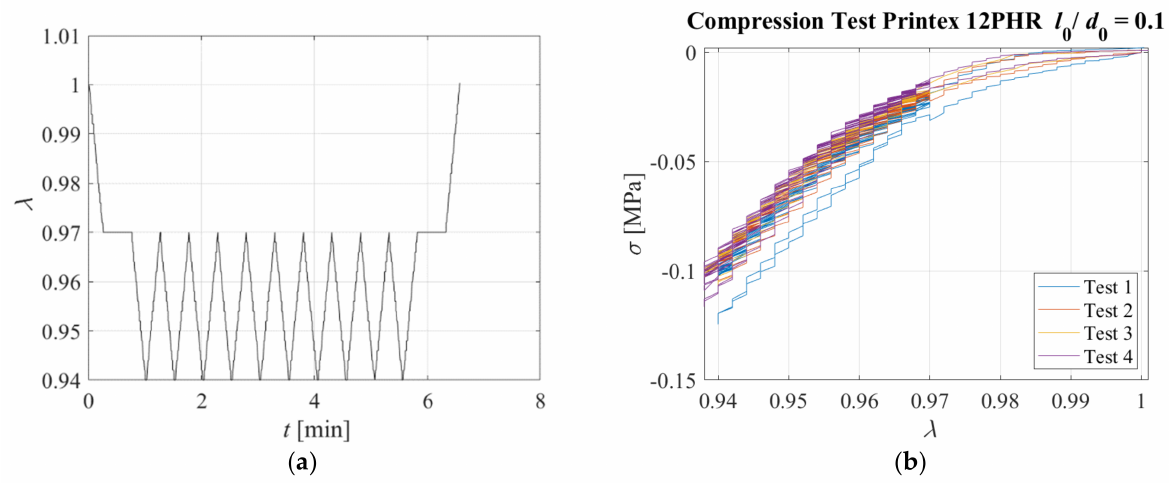
Figure 23. ( a ) Displacement pattern, ( b ) Stress − compression ratio relations for each triangular test. Specimen with l 0 / d 0 = 0.1.